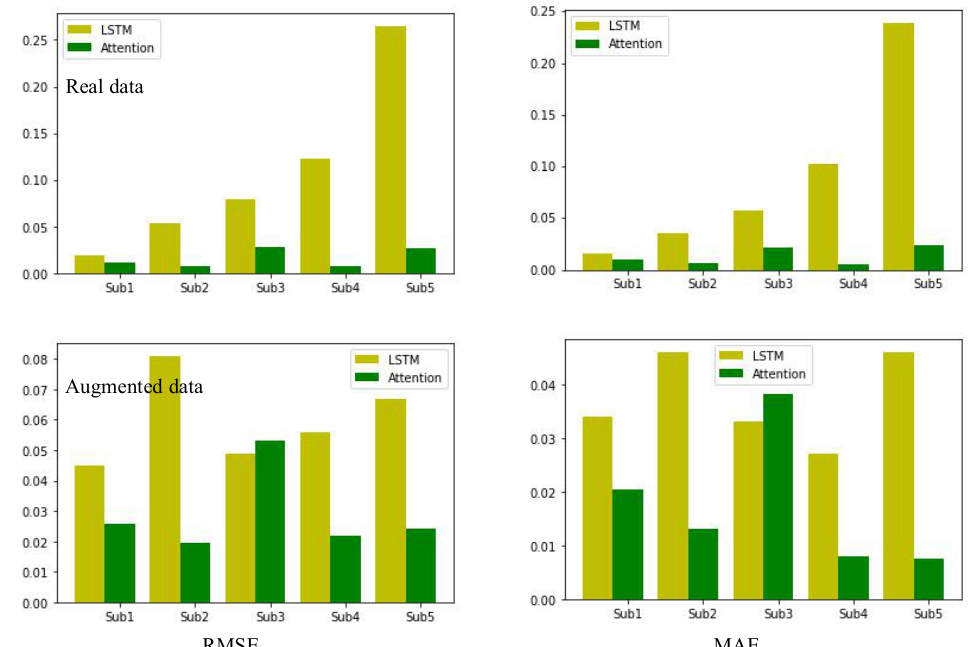
Figure 9. Prediction performance of knee joint angles across all